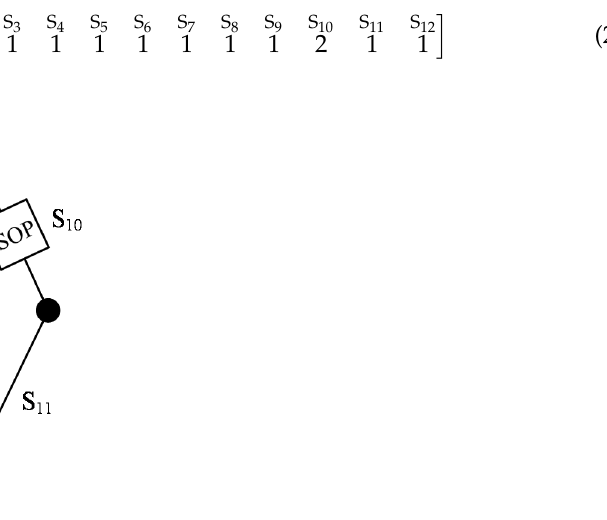
Figure 5. Candidate solution having an SOP at branch S 10 .